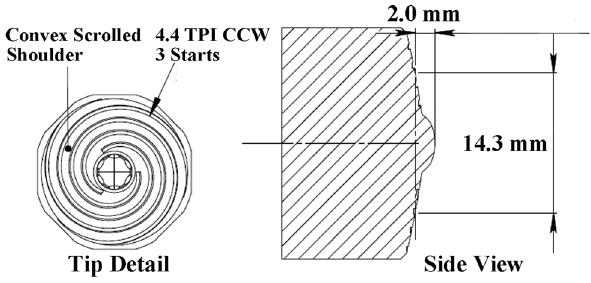
Figure 2: Geometry and dimension of the welding tool.